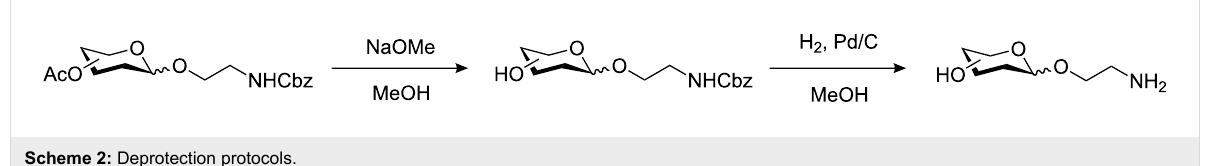
Scheme 2: Deprotection